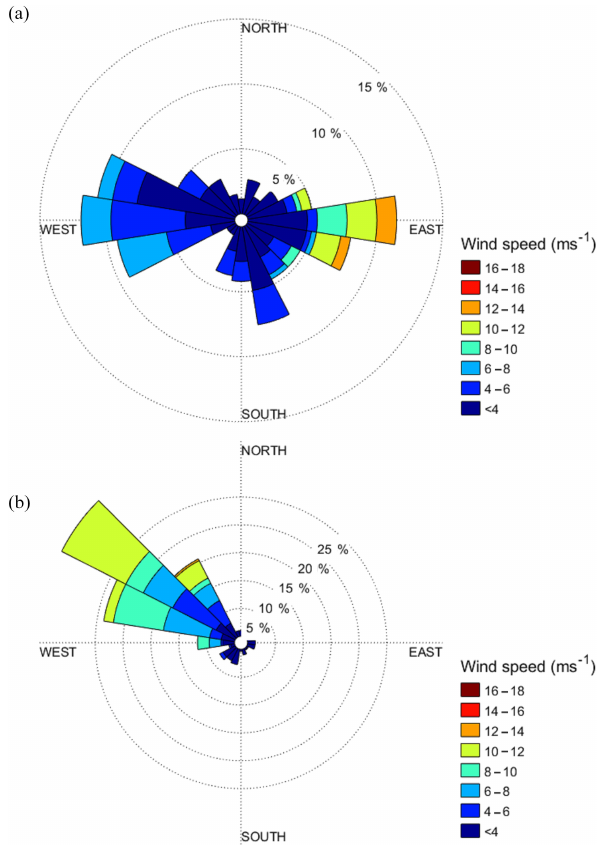
Figure 8. Same as Fig. 7 for the pressure level of 700hPa ( ∼